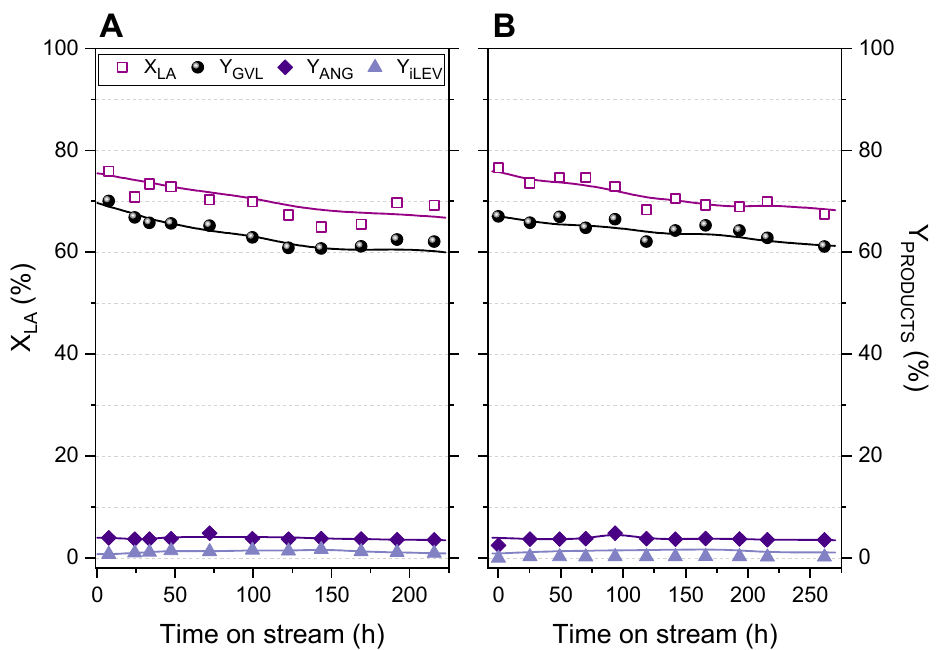
Figure 2. ( A ) Conversion and product yield profiles in the transformation of LA versus the time on stream obtained in the packed-bed reactor charged with the bifunctional Zr–Al-Beta catalyst operating under steady-state conditions. Reaction conditions: temperature = 150 °C; catalyst weight = 0.25 g; LA concentration = 6 g·L − 1 ; feed flow rate = 0.05 mL·min − 1 ; contact time = 5 min·g·mL − 1 . ( B ) LA transformation under the same reaction conditions after the in situ calcination in the air flow (5 h at 550 °C).